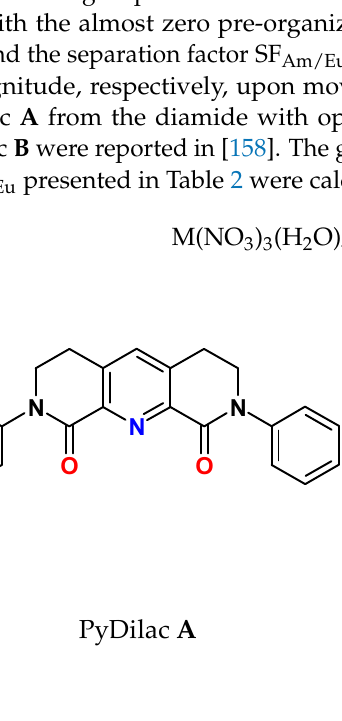
Table 2. The Gibbs energies of formation of complexes and Am-Eu separation factors, based on [53] and [158]. Me stands for Am or Eu.